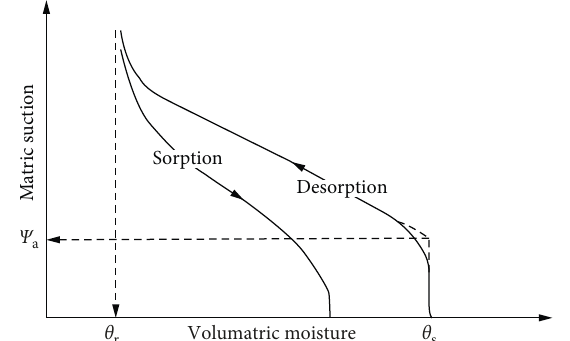
Figure 1: Description of drying (sorption) and wetting (desorp- tion) SWCC